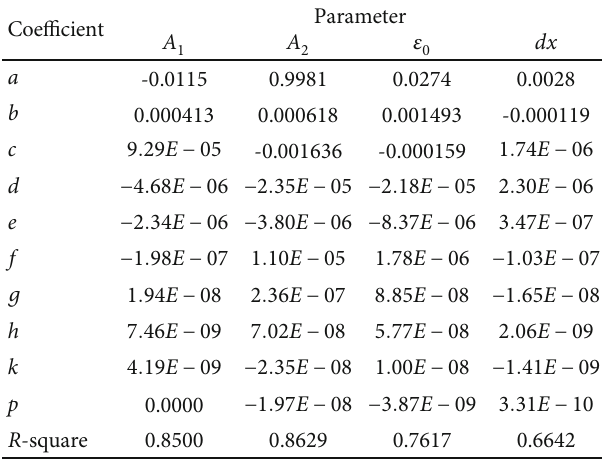
ff erent freeze-thaw cycles 2 of di